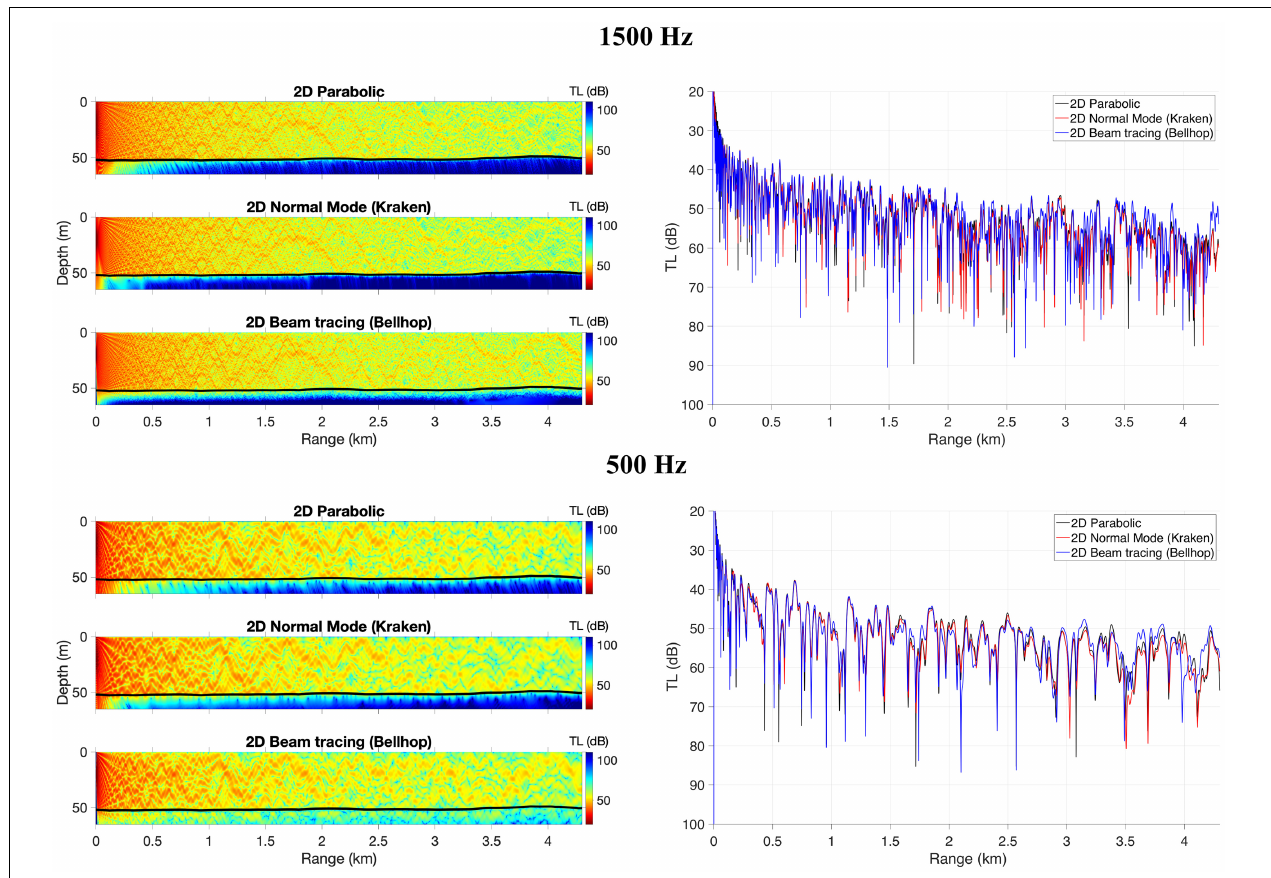
FIGURE 5 | Transmission loss for a 1500 Hz (top panel) and 500 Hz (bottom panel) sound source for an SSP range-independent [ c ( z ) ] waveguide with a rough, weakly varying bottom. Plots on the right present TL over the range at 20 m water depth. Results are presented for 2D parabolic, 2D normal mode (Kraken, mode coupling), and 2D beam tracing